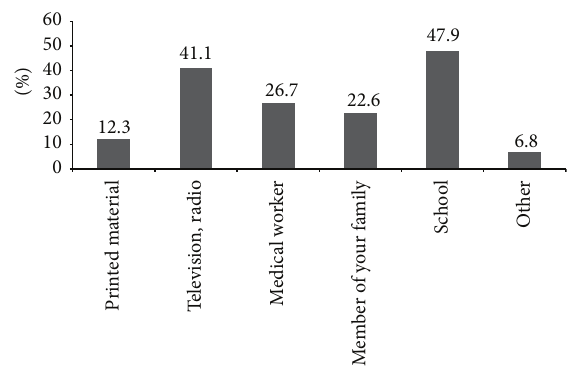
Figure 3: Routes of getting information about iodine deficiency disorders and prevention of them.